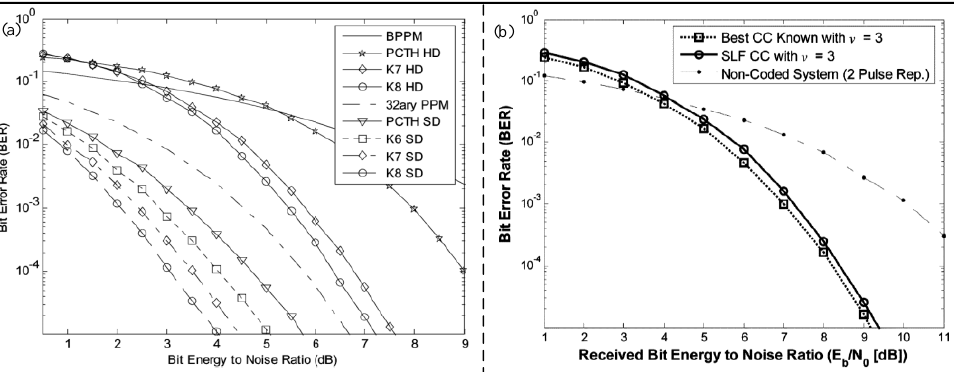
Figure 3. ( a ) BER performance for several of the rate 1 binary to 32 − ary encoders and 32 − ary PCH. (Reprinted from [32], Copyright 2007, with permission from IEEE). ( b ) BER performance in IEEE 802.15.4a CM1. (Reprinted from [33], Copyright 2011, with permission from IEEE).